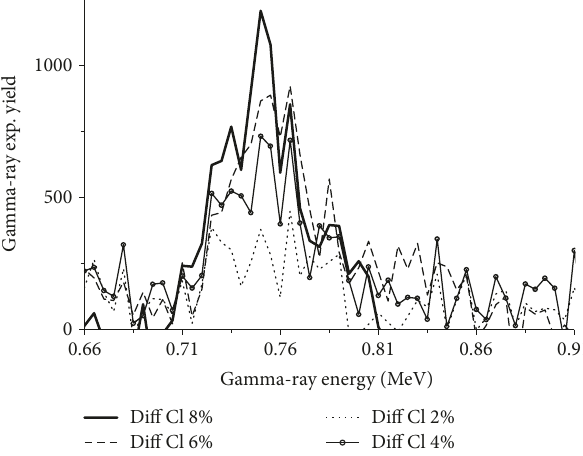
Figure 11: Pulse height di ff erence spectra of the CeBr detector 3 776 – 778 keV chlorine gamma rays from 2%, 4%, 6%, and 8% chlorine-contaminated water samples over 0.66 – 0.91MeV range superimposed upon each other.